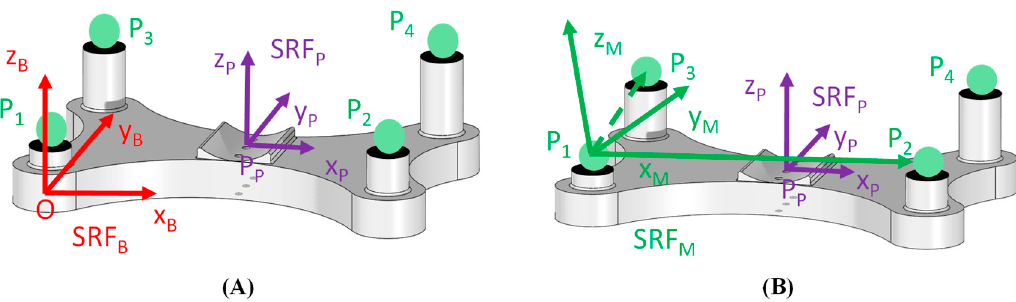
Figure 1. Graphical representation of the spatial reference frames: reference frame of the base plate SRF B and of the bone SRF P ( A ); reference frame of the markers set SRF M ( B ).